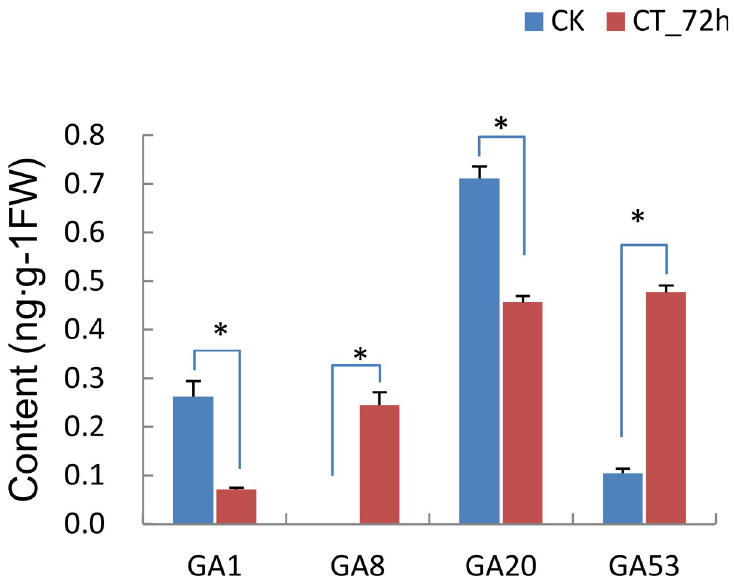
Fig 8. GA content in leaves under cold stress. Error bars indicate SE ( n = 3 biological replicates, � P < 0.05).